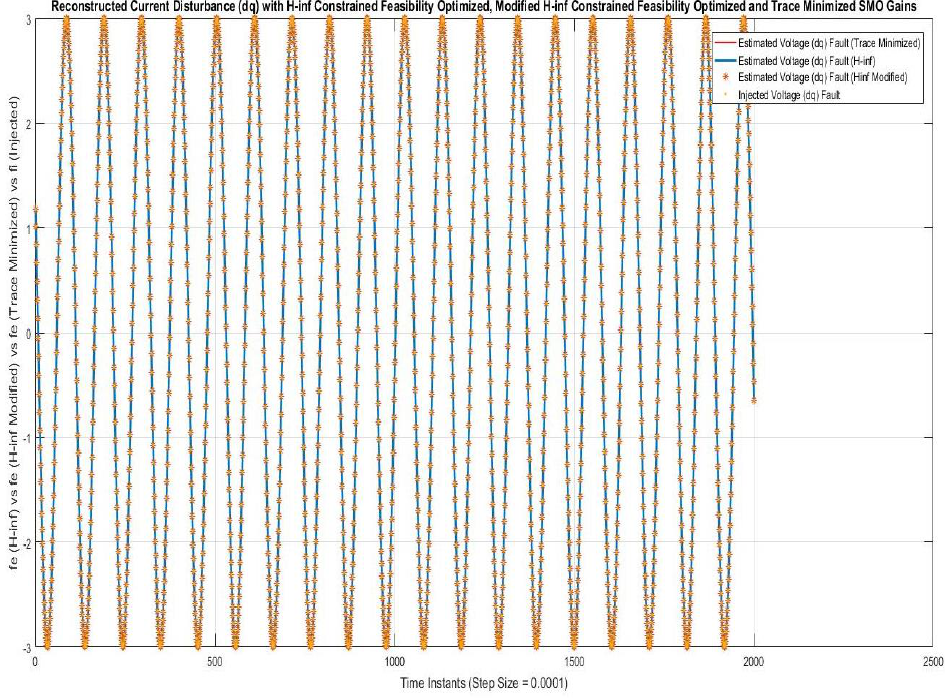
Figure 12. Current (dq) disturbance